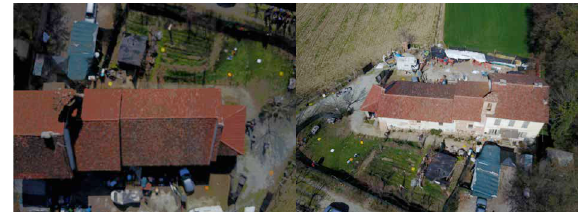
Figure 7. Example of blurry images acquired by the Mavic Pro using Pix 4D